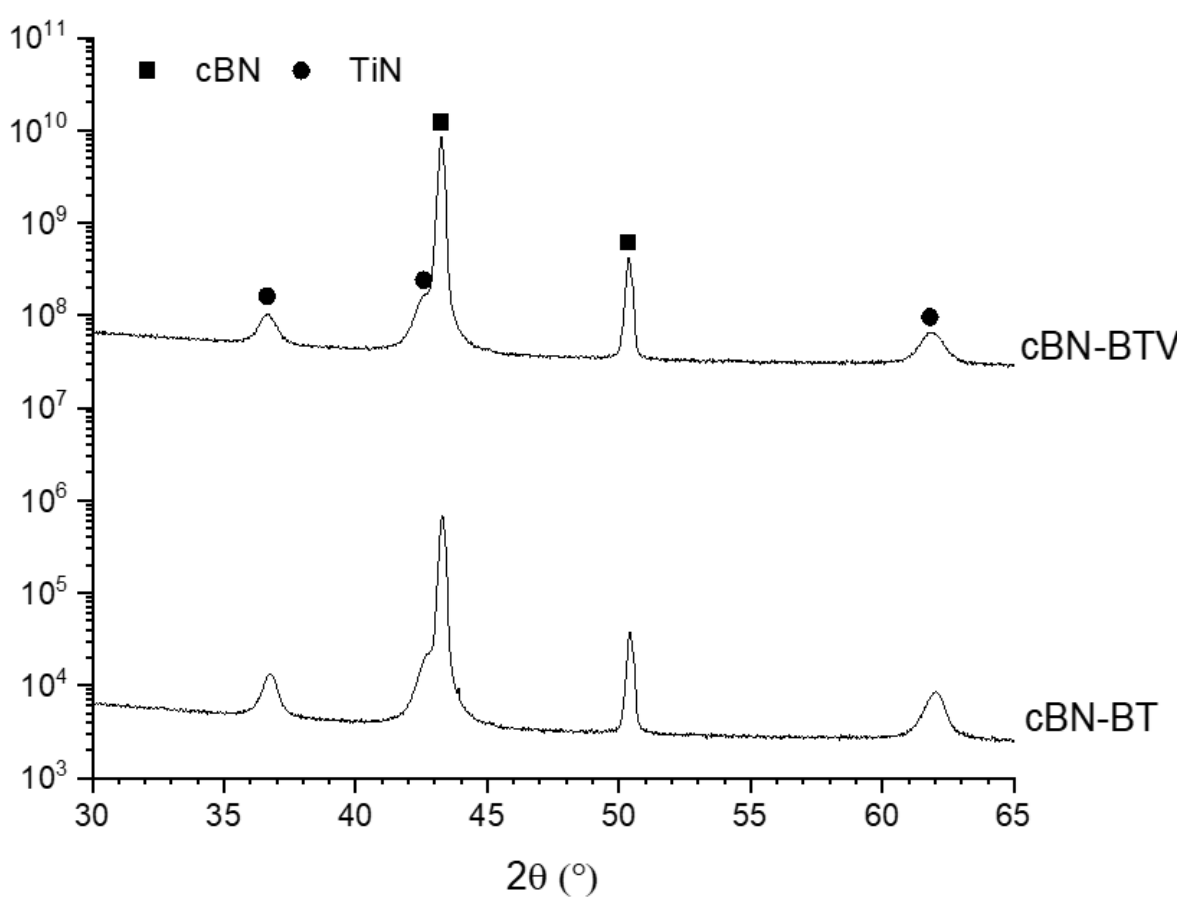
Figure 2. XRD-pattern of the TiN coated cBN powders BT and BTV.